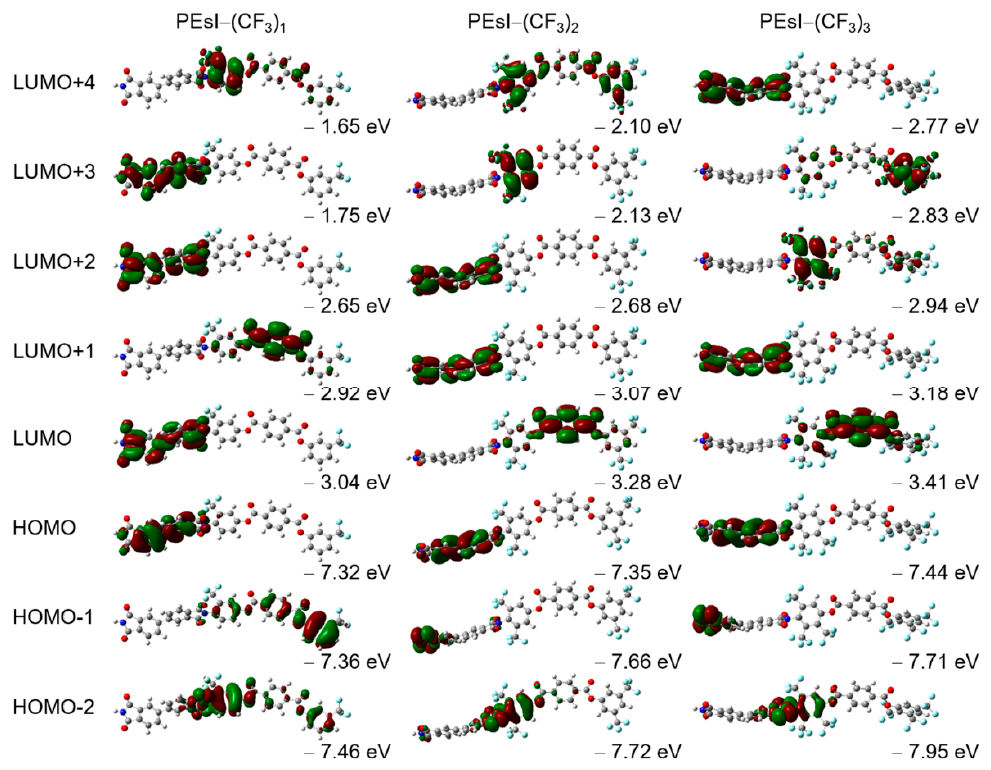
Figure 3. Calculated molecular orbitals and the corresponding energy levels of the repeating units of PEsI–(CF 3 ) x model compounds using the Becke, three-parameter, Lee-Yang-Parr (B3LYP) level with the 6-31G basis set (B3LYP/6-31G).